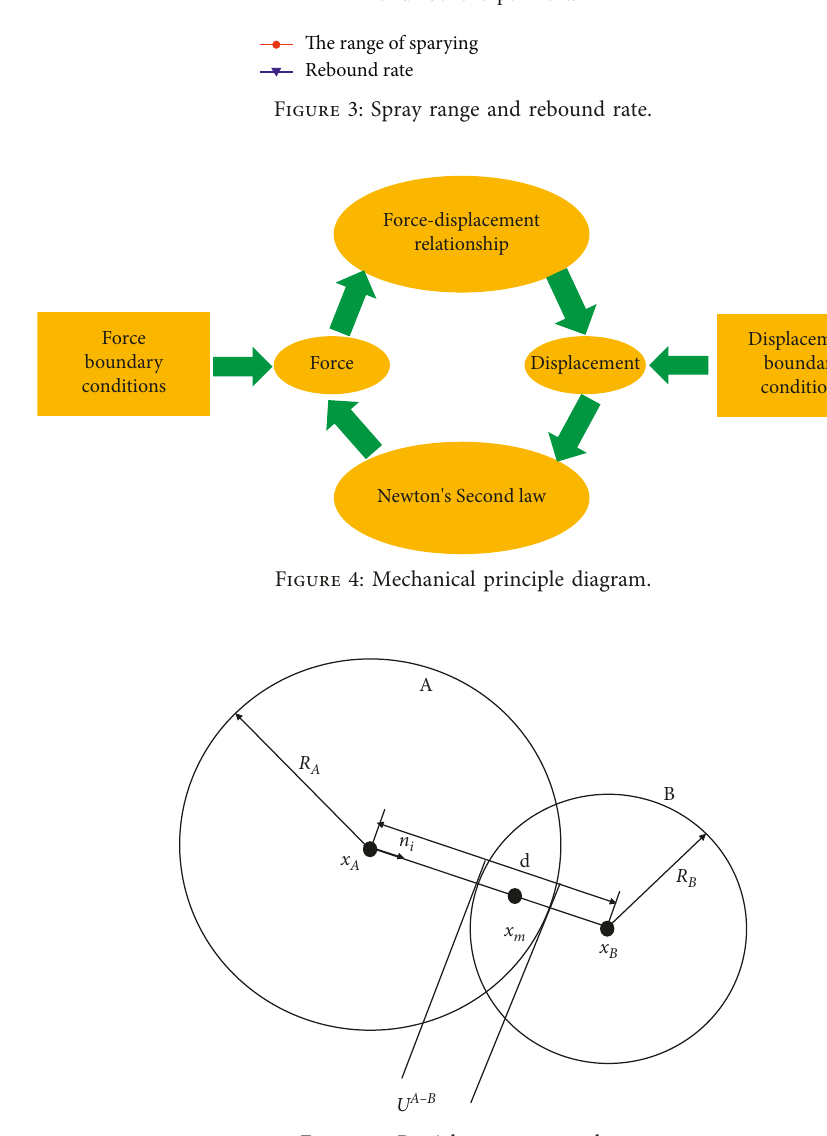
Figure 5: Particles contact